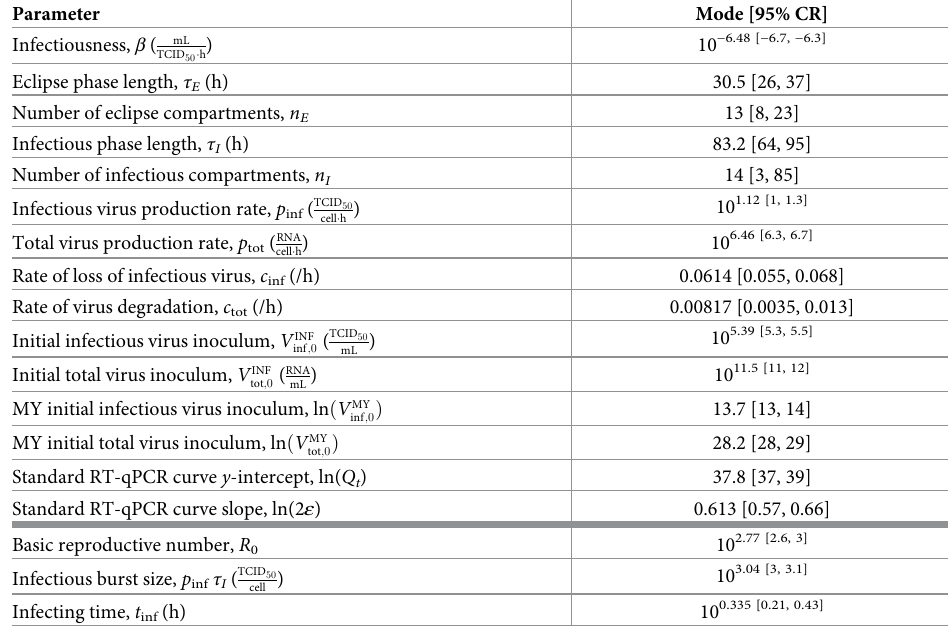
Table 1. Estimated parameters of EBOV infection in vitro .